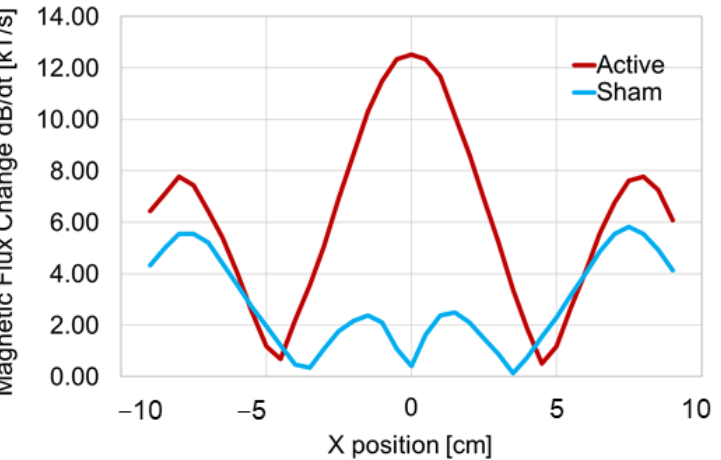
Figure 4. Schematic diagrams of the magnetic fields generated by the active and sham coils. The horizontal axis shows the position of the search coil in the coil to be measured and the vertical axis shows the magnetic flux change. The position of the search coil in the coil to be measured is shown on the horizontal axis, and the vertical axis shows the magnetic flux change. The center of the coil to be measured was set at X = 0 cm, and measurements were taken up to a position of 9 cm on either side. The red line represents the results of the active coil and the blue line shows the results of the sham coil. In the active coil, three peaks of magnetic flux change were observed, while in the sham coil, four peaks of magnetic flux change were observed.